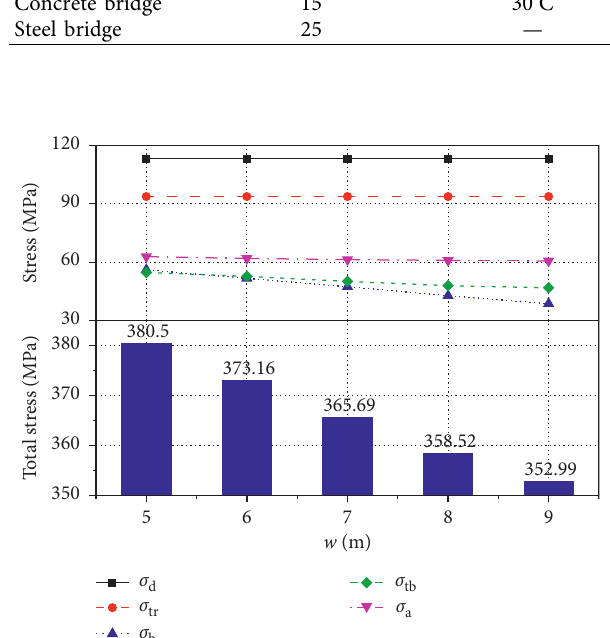
Figure 6: Rail stress in the CDTWP